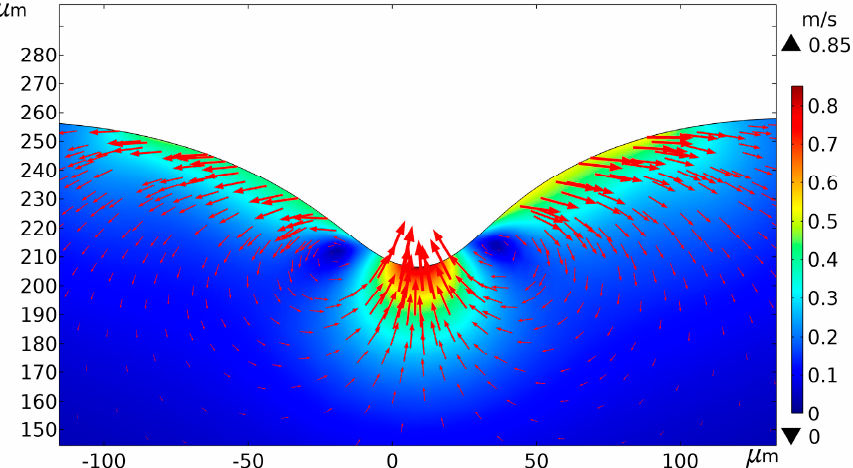
Figure 6. Flow field velocity of the melt pool. (Average power = 8 W, pulse width = 40 ns, frequency = 150 kHz, scanning speed = 100 mm/s).